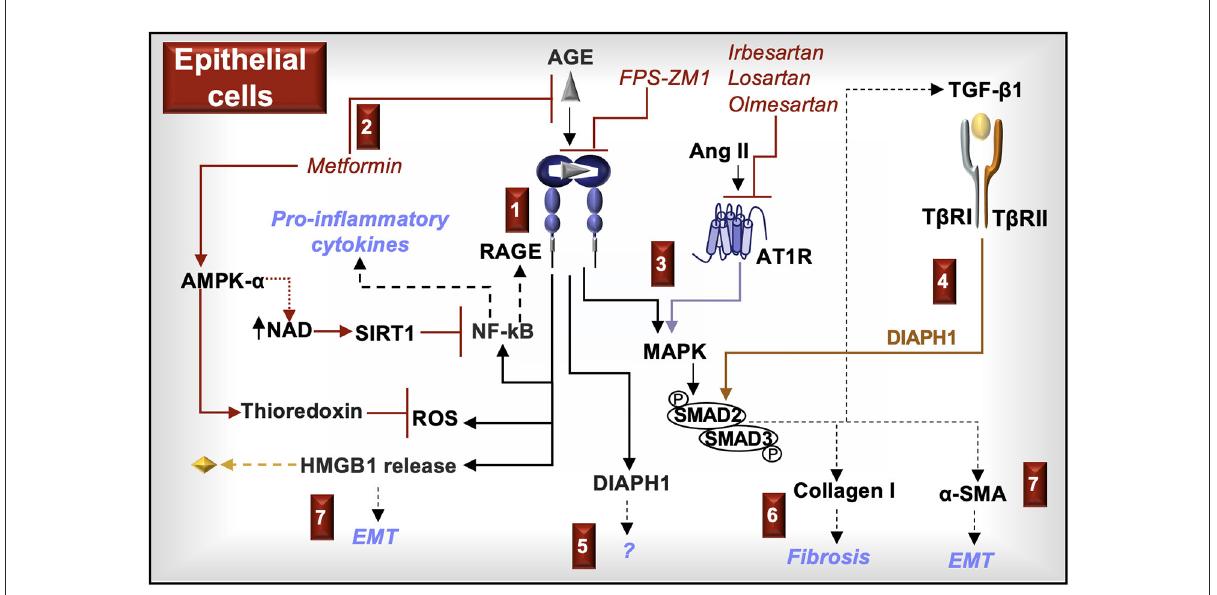
FIGURE5 RAGE signaling in epithelial cells . (1) AGE activation of RAGE in kidney epithelial cells increases reactive oxygen species (ROS), induces the activation of NF- κ B, and promotes the release of HMGB1. ROS in association with NF- κ B-induced cytokines and increased RAGE expression promote inflammation. (2) Metformin, in addition to being a hypoglycemic agent, prevents RAGE signaling by inhibiting the formation of α -dicarbonyl AGE and activating AMP-activated protein kinase (AMPK)- α , which increases the production of NAD and the antioxidant, thioredoxin. NAD promotes the activity of sirtuin-1 (SIRT1) and deacetylates/inactivates the NF- κ B subunit p65. (3) RAGE and the Ang II type I receptor (AT1R) activate MAPK (e.g., ERK/p38 MAPK) and SMAD2/3, which promote the production of TGF- β 1, type I collagen, and α -smooth muscle actin (SMA). (4) TGF- β 1 induces SMAD2/3 and their downstream responses in a DIAPH1-dependent manner. (5) DIAPH1 is directly activated by the cytoplasmic tail of RAGE. RAGE-induced DIAPH1 functions in kidney epithelial cells are not fully known. (6) Type I collagen deposition promotes fibrosis. (7) HMGB1 promotes the production of TGF- β 1 and α -SMA in a RAGE dependent manner. Increased production of α -SMA promotes epithelial mesenchymal transition